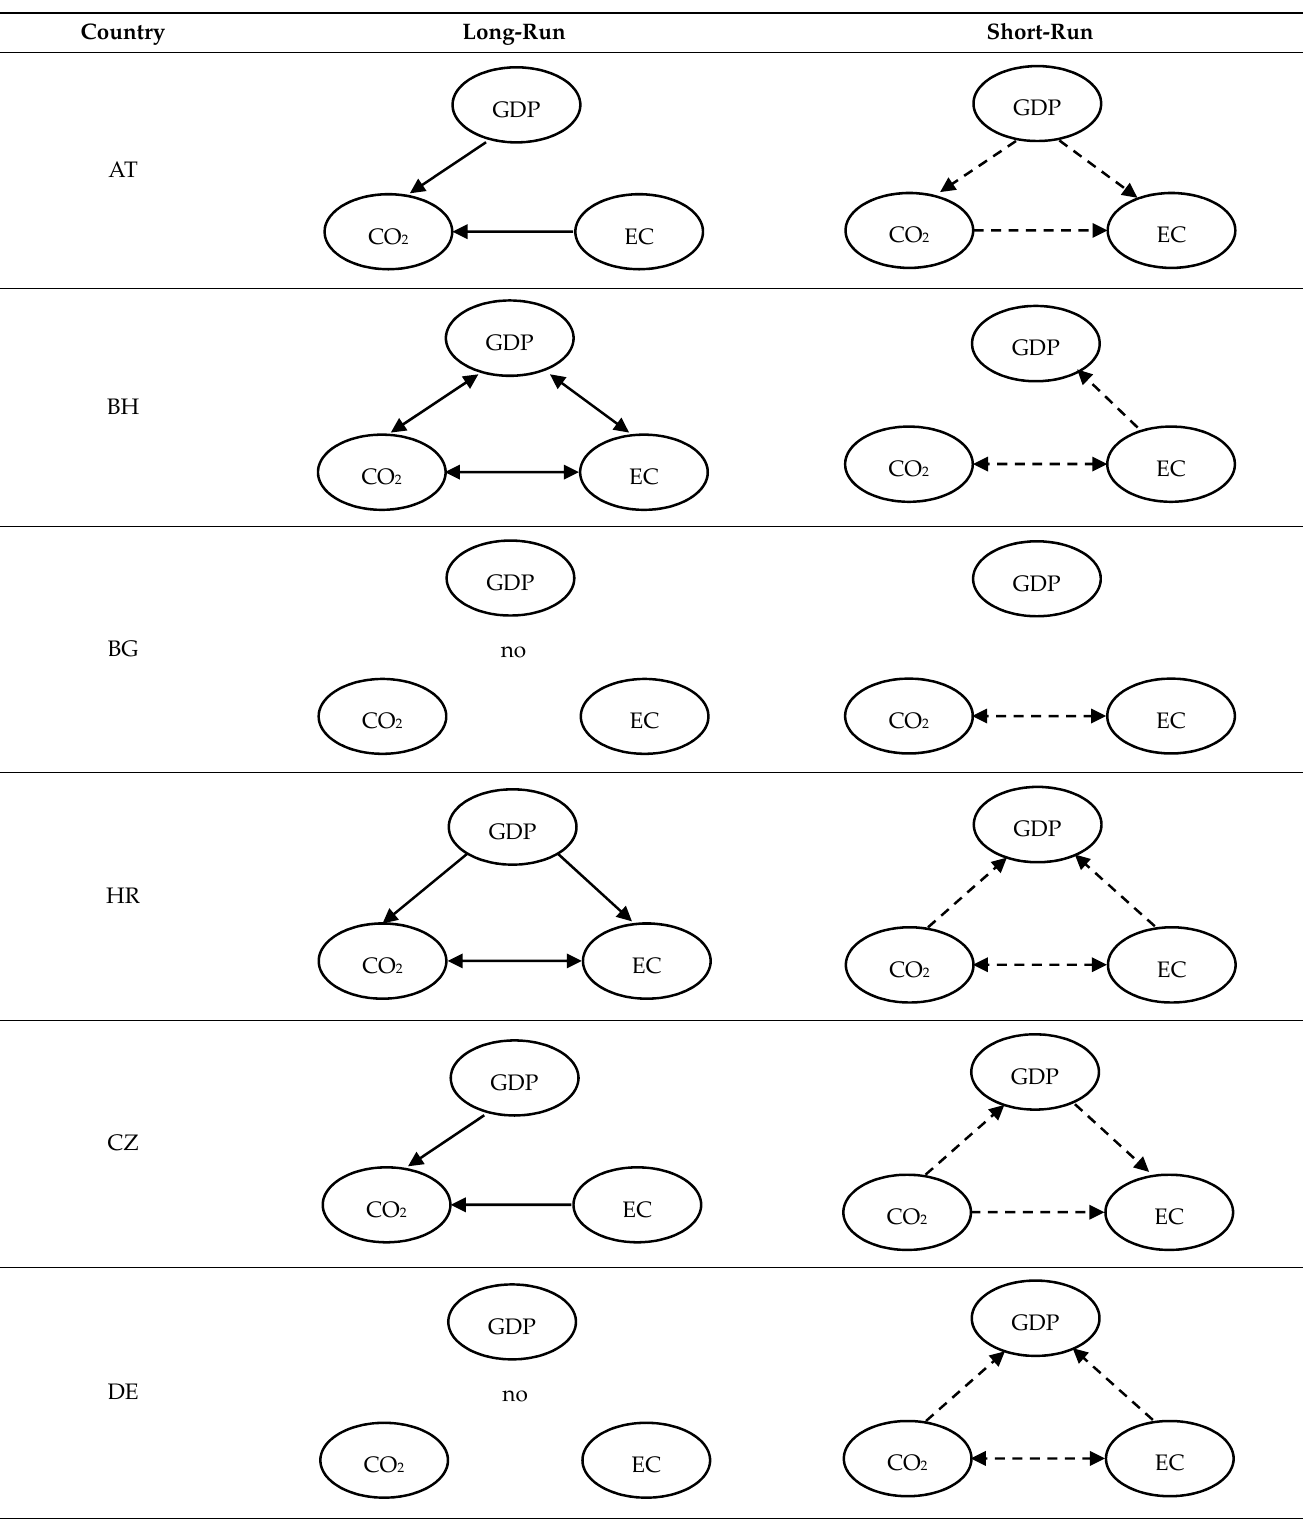
Table 5. Relationship between variables.